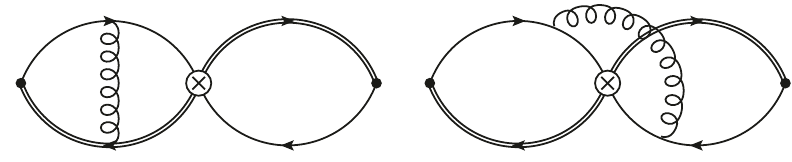
Figure 2 . Examples for factorizing (left) and non-factorizing (right) contributions to the three- point correlator (2.22) at NLO in (cid:11) s